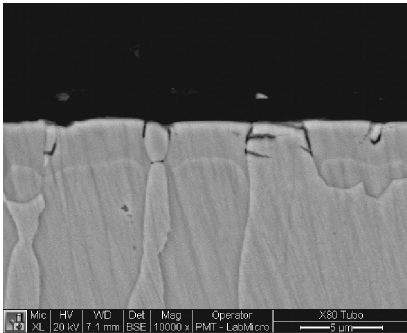
Figure 2. Nitrided layer obtain at 400 °C.